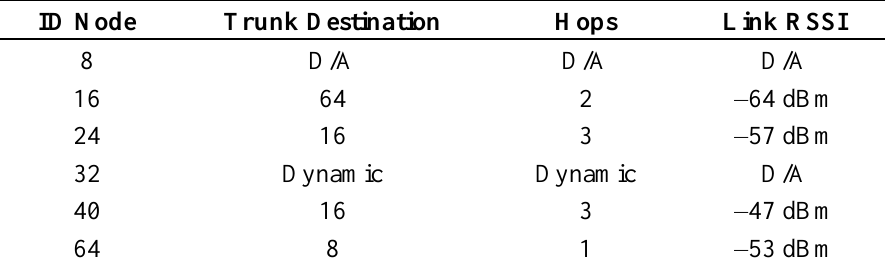
Table 5. Scenario routing table.